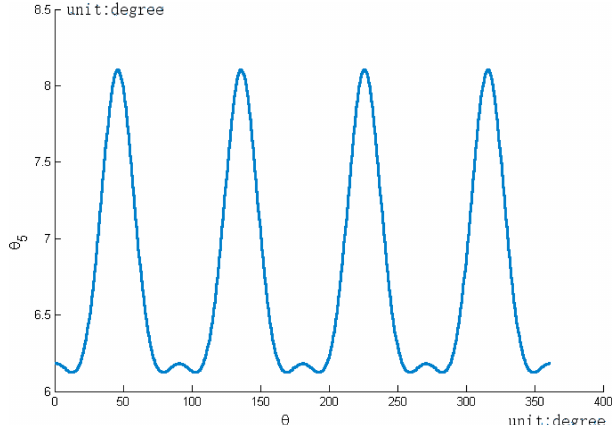
Figure 4. The relationship between the θ 5 and the perigon.